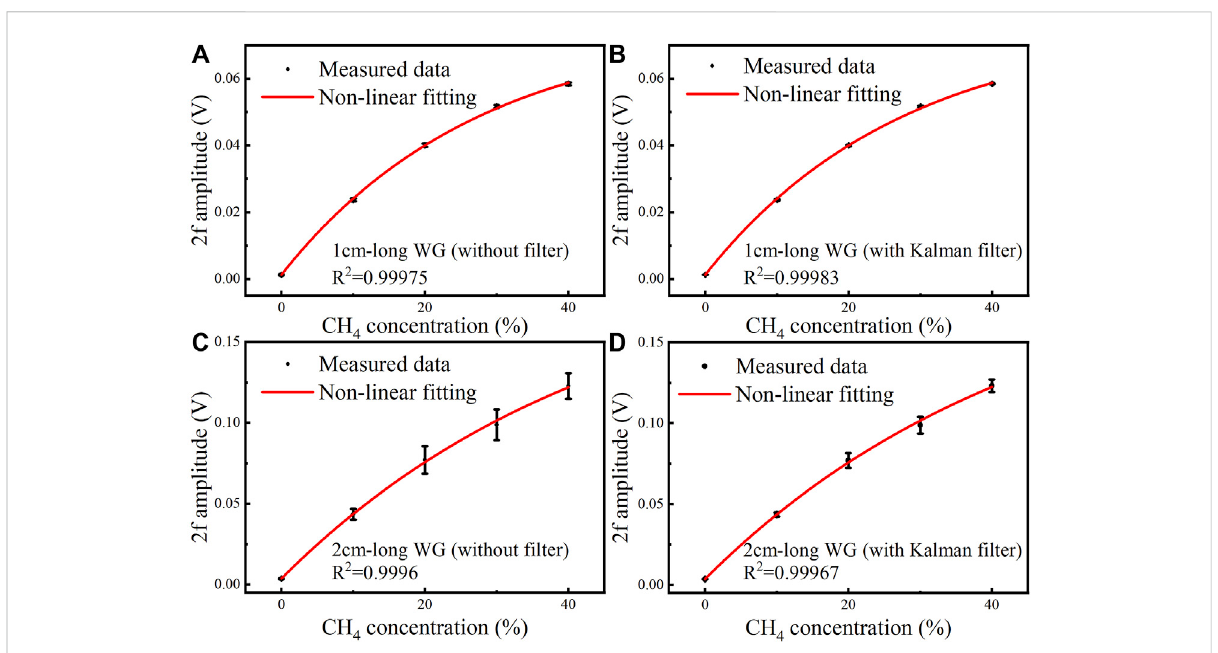
FIGURE 8 Measured data and non-linear fi tting curve of the 2f signal amplitude versus CH 4 concentration of the 1 cm-long waveguide under different CH 4 concentration levels of 0, 10, 20, 30 and 40% (A) without Kalman fi lter and (B) with Kalman fi lter. Measured data and non-linear fi tting curve of the 2f signal amplitude versus CH 4 concentration of the 2 cm-long waveguide under different CH 4 concentration levels of 0, 10, 20, 30 and 40% (C) without Kalman fi lter and (D) with Kalman fi